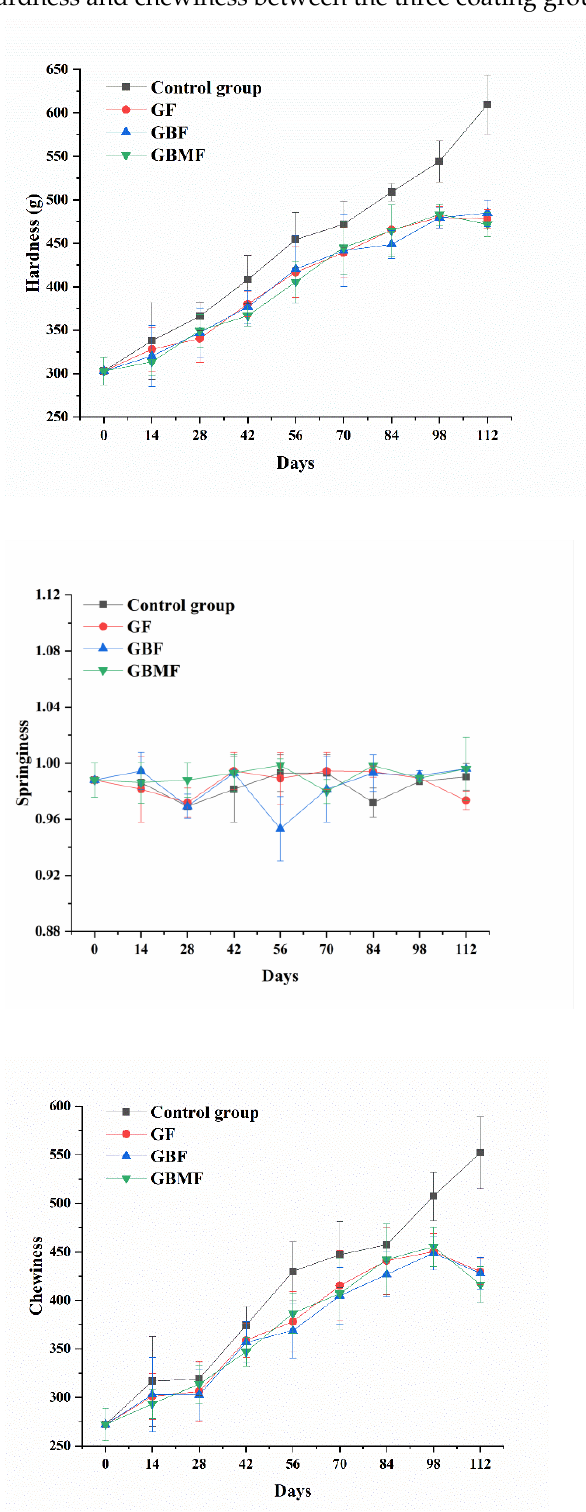
Figure 6. Changes of texture characteristics of preserved egg white coated with different films.